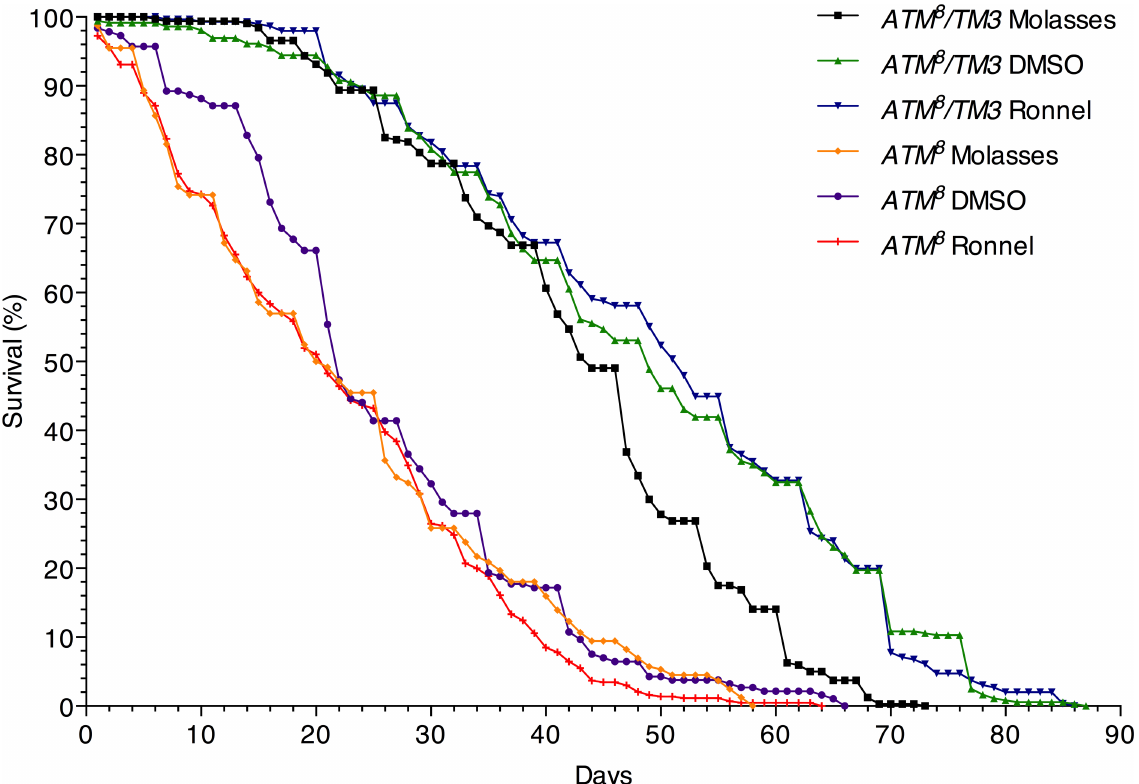
Fig 2. Ronnel does not affect the lifespan of ATM 8 flies. The survival of ATM 8 and ATM 8 /TM3 flies raised on the indicatedfood source was monitoredover time until all of the flies had died. ATM 8 molasses(n = 244), ATM 8 0.2% DMSO (n = 186), ATM 8 0.02 mM Ronnelin 0.2% DMSO (n = 435), ATM 8 /TM3 molasses(n = 320), ATM 8 /TM3 0.2% DMSO (n = 360), and ATM 8 /TM3 0.02 mM Ronnelin 0.2% DMSO (n =